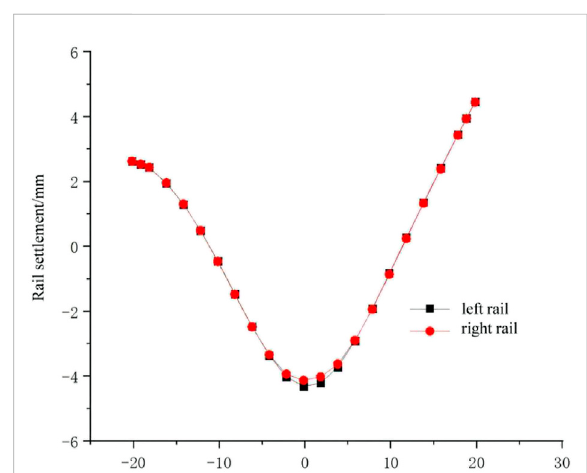
FIGURE 13 Ground surface settlement curve of cross Section 2 during pilots under-passing existed railway line.